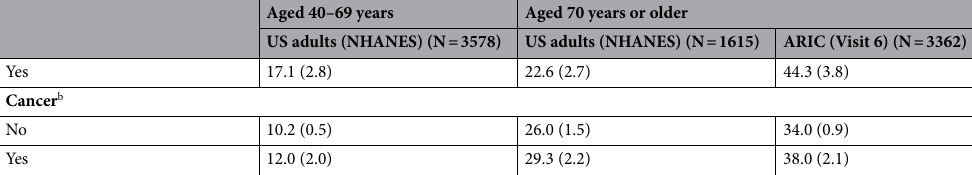
Table 2. Age, sex, and race-adjusted prevalence [% (SE)] of peripheral neuropathy by demographic and risk factor categories among US adults aged 40–69 and ≥ 70 years (NHANES, 1999–2004) and ARIC participants aged ≥ 70 years (Visit 6, 2016–2017). a Prevalences are among participants who were not missing data for peripheral artery disease: N = 3215 in NHANES aged 40–69 years, N = 1204 in NHANES aged ≥ 70 years, and N = 2971 in ARIC visit 6. b Prevalence for the ARIC study is among participants who were not missing cancer status in ARIC visit 6, N = 3136.